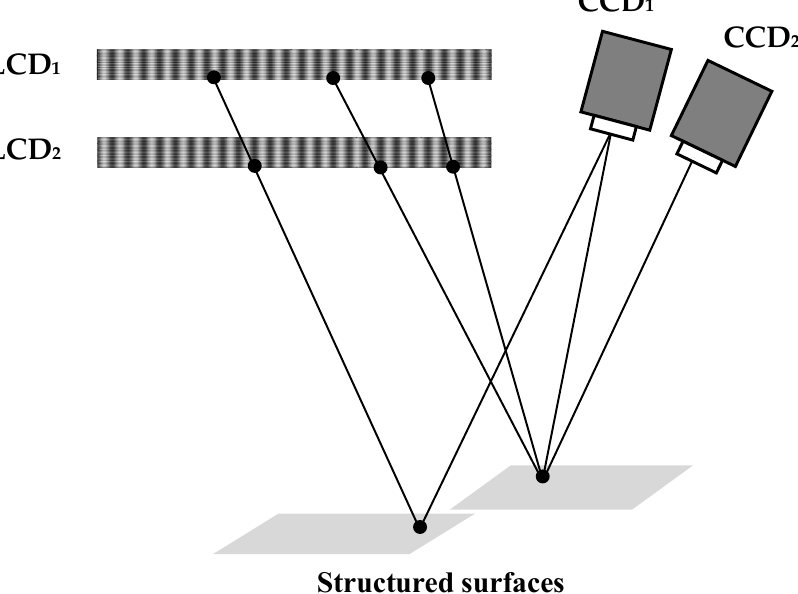
Figure 2. Measurement diagram.